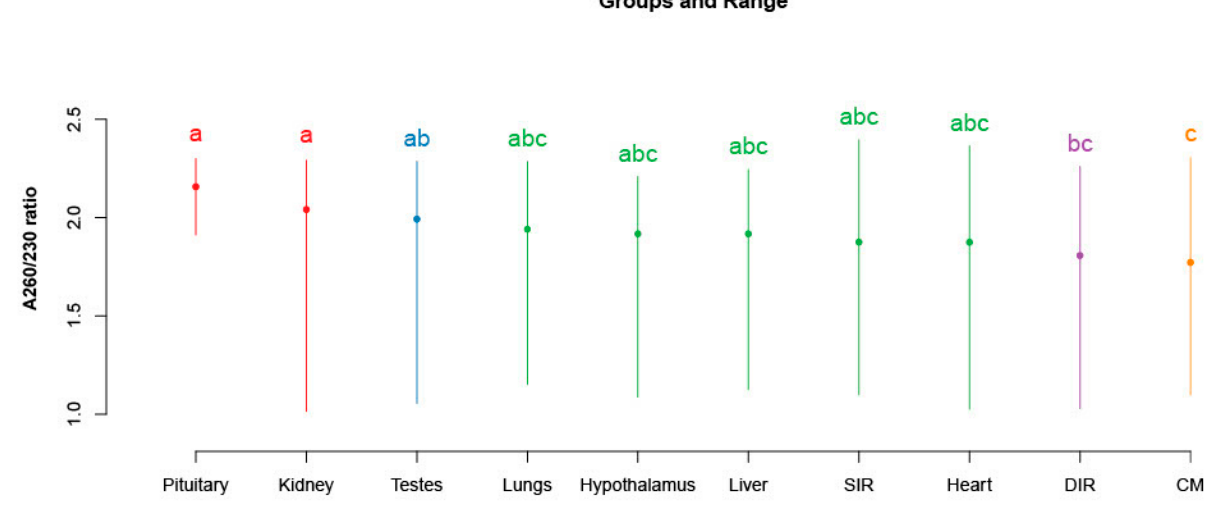
Figure 4. Post hoc analysis confirms the significant effect of tissue types on the A260/230 ratio. Range of the A260/230 ratio and means (dots) per tissue types are marked in the figure. Groups carrying different superscript letters and colours differ significantly ( p < 0.05) CM: cremaster muscle; DIR: deep inguinal ring; SIR: superficial inguinal ring.